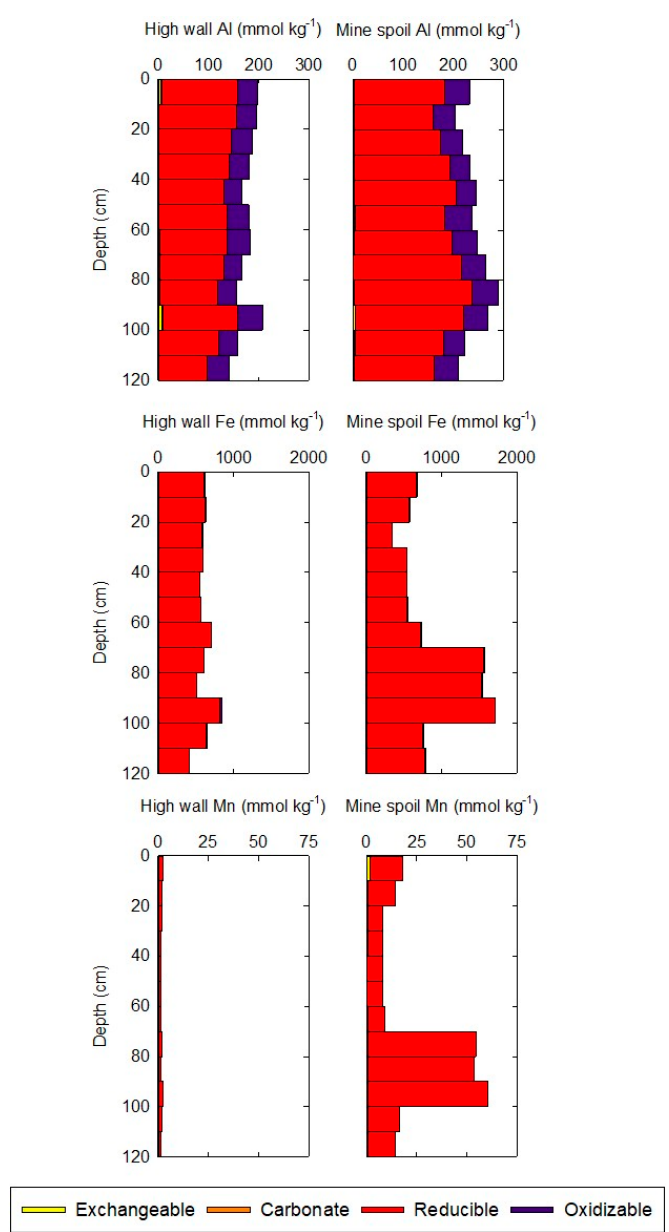
Figure 8. Total extractable Al ( top ), Fe ( middle ), and Mn ( bottom ) showing contributions of ex- changeable (yellow), carbonate (orange), reducible (red), and oxidizable (blue) components from the high wall ( left ) and mine spoil ( right ) soil cores. Individual extractions, including the analytical error, are shown in Figure S7.